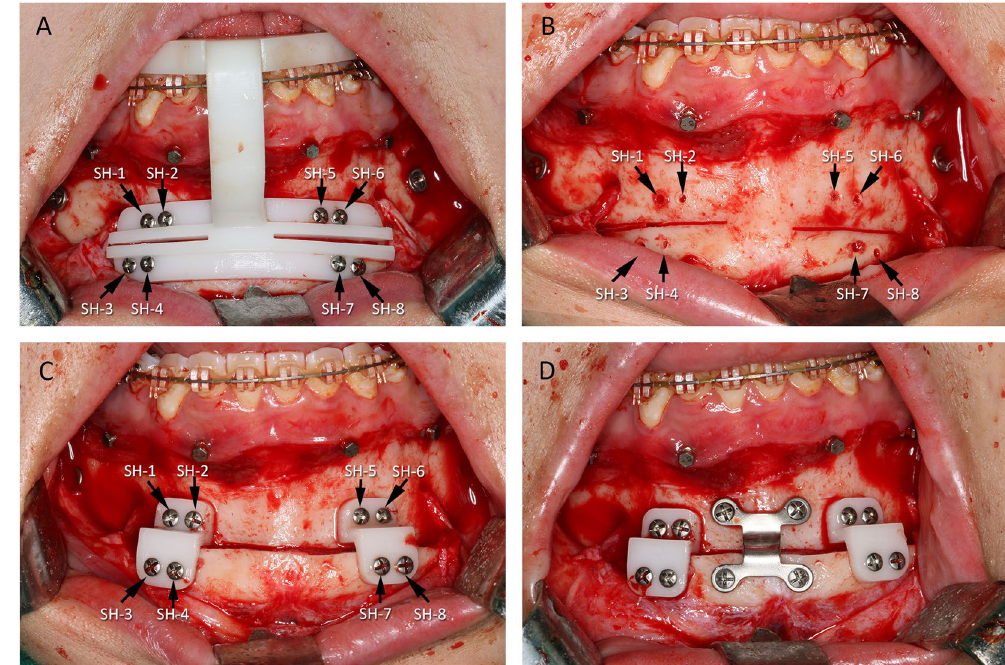
Figure 2. ( A ) During the operation, the cutting guide was positioned on the mandibular dentition exactly as planned. The lower portion of the guide was attached firmly to the chin by eight screws using the drilling holes. The resection margins guided the saw blade to perform the osteotomy as planned. ( B ) The cutting guide and the screws were removed to complete the osteotomy after the cutting lines had been marked and the screw holes had been drilled. ( C ) A pair of the repositioning guides were installed on the distal mandible by alignment with the previously drilled screw holes on the distal mandible. When the four corresponding screw holes on both sides of the chin segment and the guide were aligned, the chin segment was automatically moved to its final planned position and secured temporarily. ( D ) The chin segment was stabilized by rigid fixation. Then, the guide and associated screws were removed. (SH: screw